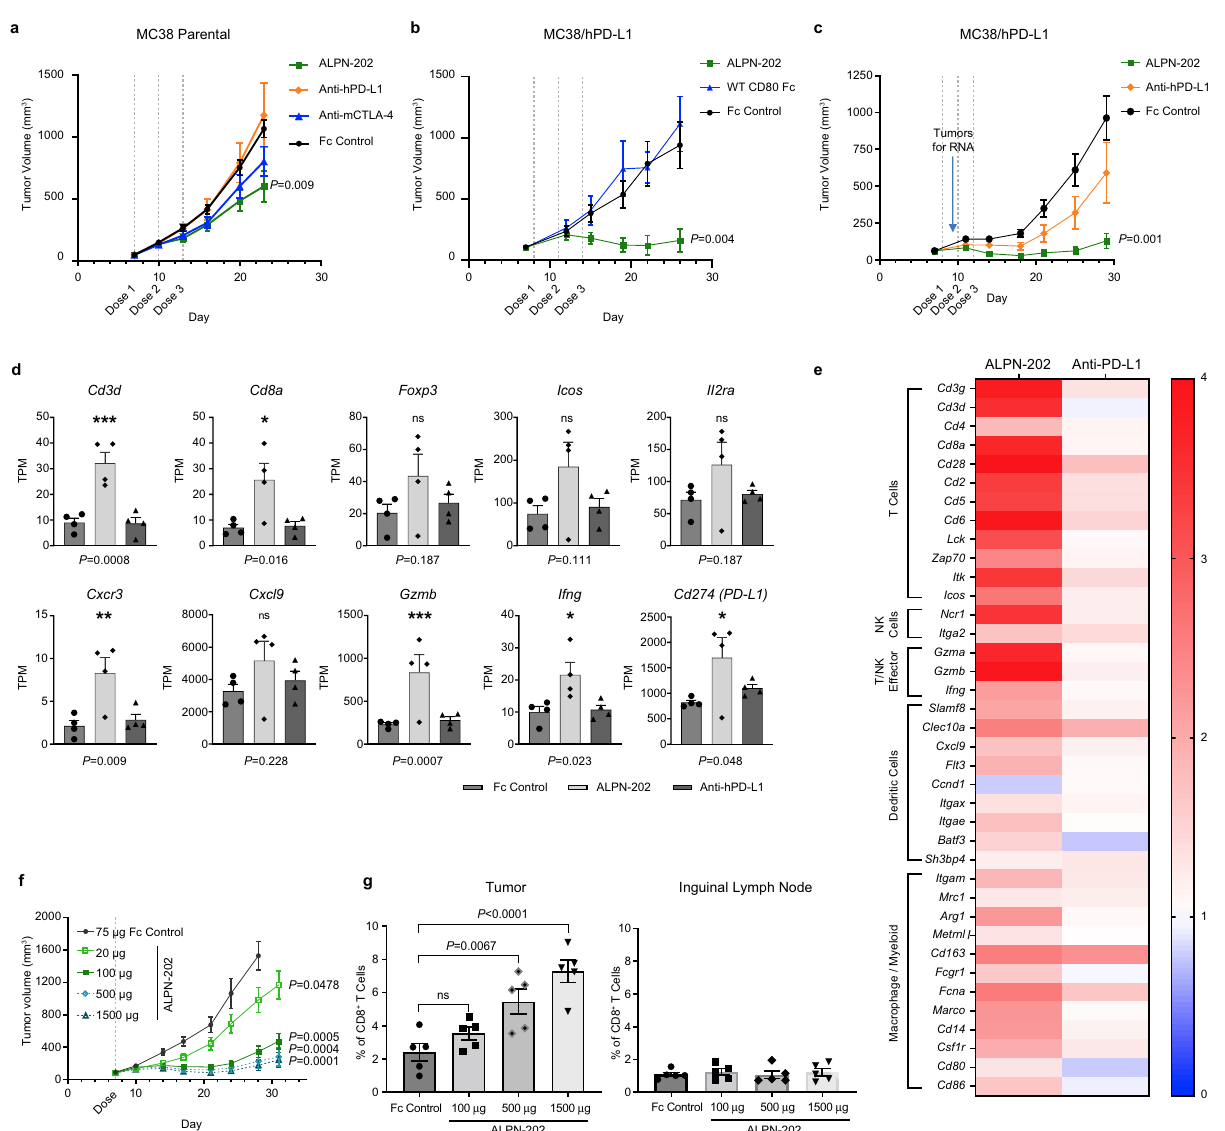
Fig. 5 ALPN-202 demonstrates potent and dose-dependent anti-tumor activity in vivo in a MC38/human PD-L1 tumor model. a ALPN-202 induced a small but signi fi cant decrease in tumor growth relative to Fc control in a parental MC38 tumor model. ( n = 10 mice/group). b , c In MC38/hPD-L1 tumor studies, ALPN-202-mediated anti-tumor activity (green) was superior to wild type WT CD80 ECD-Fc (blue), anti-PD-L1 (durvalumab, orange), or isotype control (black) ( n = 10 mice/group). WT wild type; ECD extracellular domain. d A subset of tumors from study shown in ( c ) were harvested 72 h after the fi rst dose and RNAseq performed. Transcripts per kilobase million reads (TPM) of select genes for individual tumors are shown. Individual points represent TPM for individual tumor samples and bars indicate mean values ± SEM. e Signature transcripts from the indicated immune cell populations were identi fi ed using the ImmGen Population Comparison application [https://www.immgen.org/ImmGenpubs.html]. The heatmap compares the fold increase (red) or decrease (blue) in mean transcript levels of either ALPN-202-treated or anti-PD-L1 treated tumors relative to Fc-control-treated tumors ( n = 4 tumor samples per group). f ALPN-202-treated MC38/hPD-L1 tumors ( n = 12 mice/group) showed a dose-dependent increase in anti-tumor activity. g 72 h after treatment there was a dose-dependent increase in intratumoral p15E + tumor antigen-speci fi c CD8 + T cells. No change was observed in inguinal lymph nodes. N = 5 samples from each group (individual symbols) and bar height indicates mean percentage of p15E + CD8 + T cells. Error bars are SEM. Gating strategy is summarized in Supplementary Fig. 7. Statistical signi fi cance was determined by one-way ANOVA with Dunnett ’ s multiple comparisons test ( d , g ) or by repeated-measures two-way ANOVA for treatment effects ( a , b , c , f ). P values shown are ALPN-202 vs Fc control. For all studies except ( f , g ), antibodies and ALPN-202 were treated at 100 µ g/dose while Fc control was 75 µ g/dose. For all graphs, the means ± SEM are shown. Source data are provided as a Source Data fi relative to WT CD80 Fc (Fig. 5b) or anti-human PD-L1 treatment (Fig. 5c).